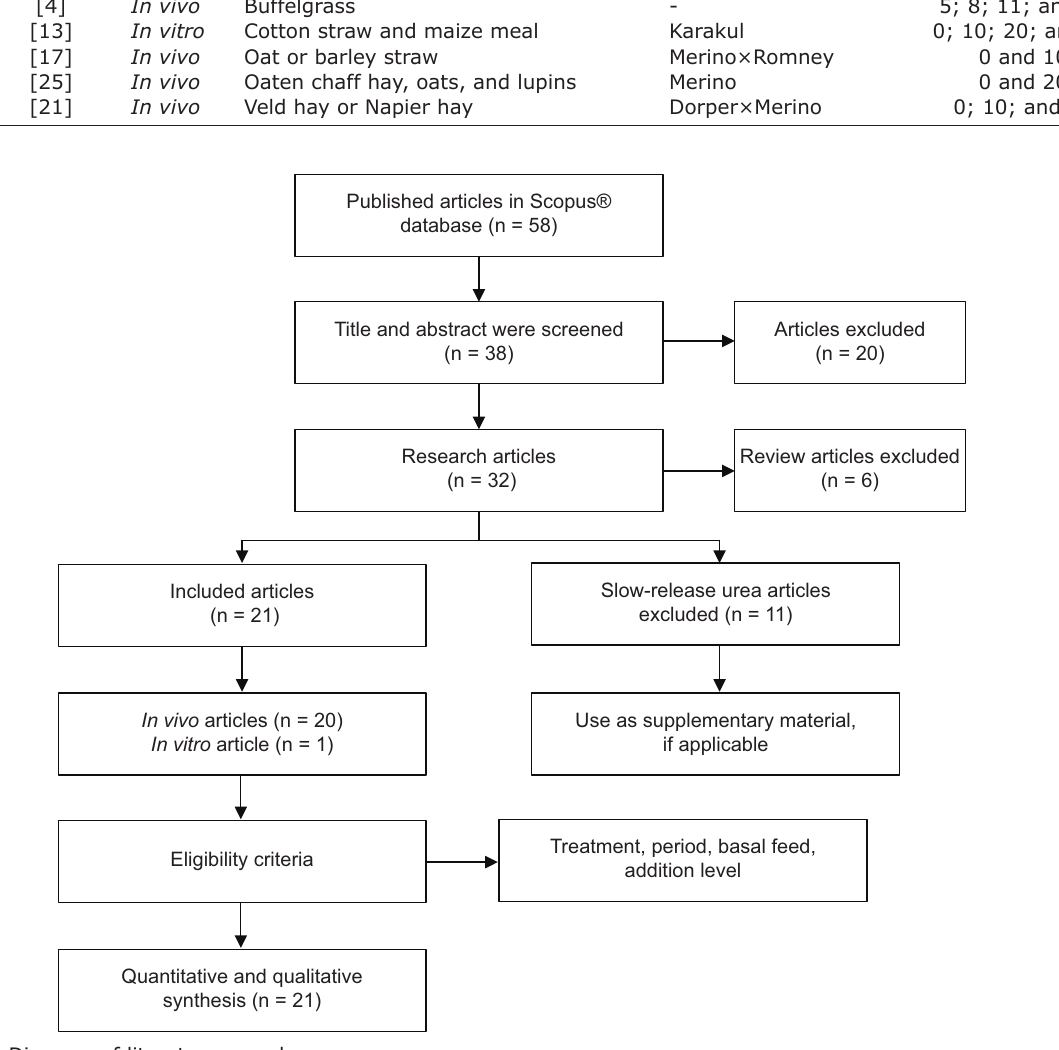
Figure-1: Diagram of literature